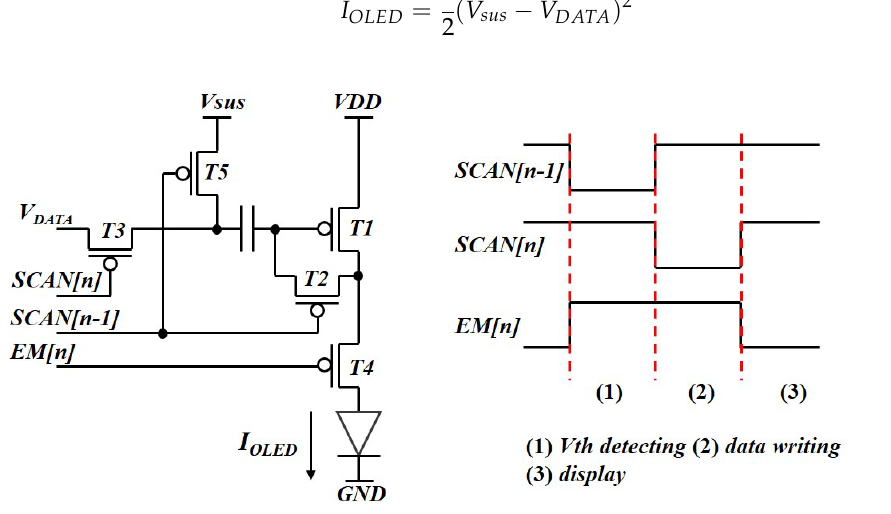
Figure 5. Example organic light-emitting diode (OLED) pixel circuit with threshold voltage and supply voltage drop compensation